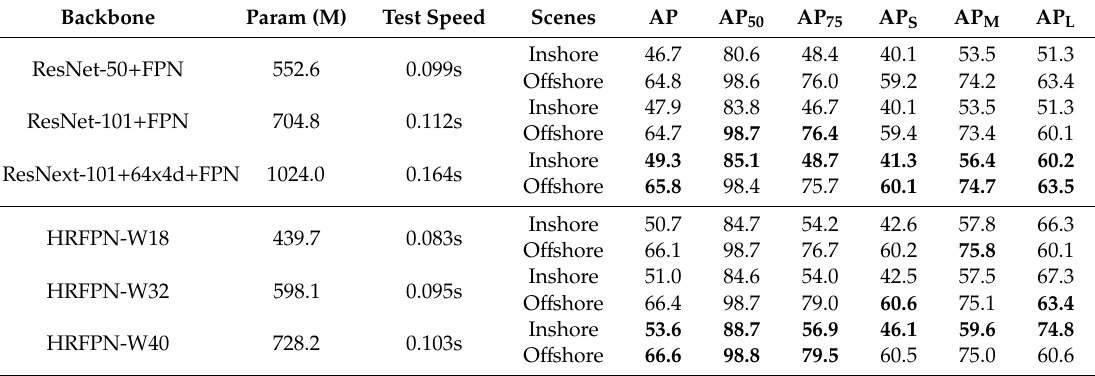
Table 3. E ff ect of the HRFPN in the Inshore and O ff shore